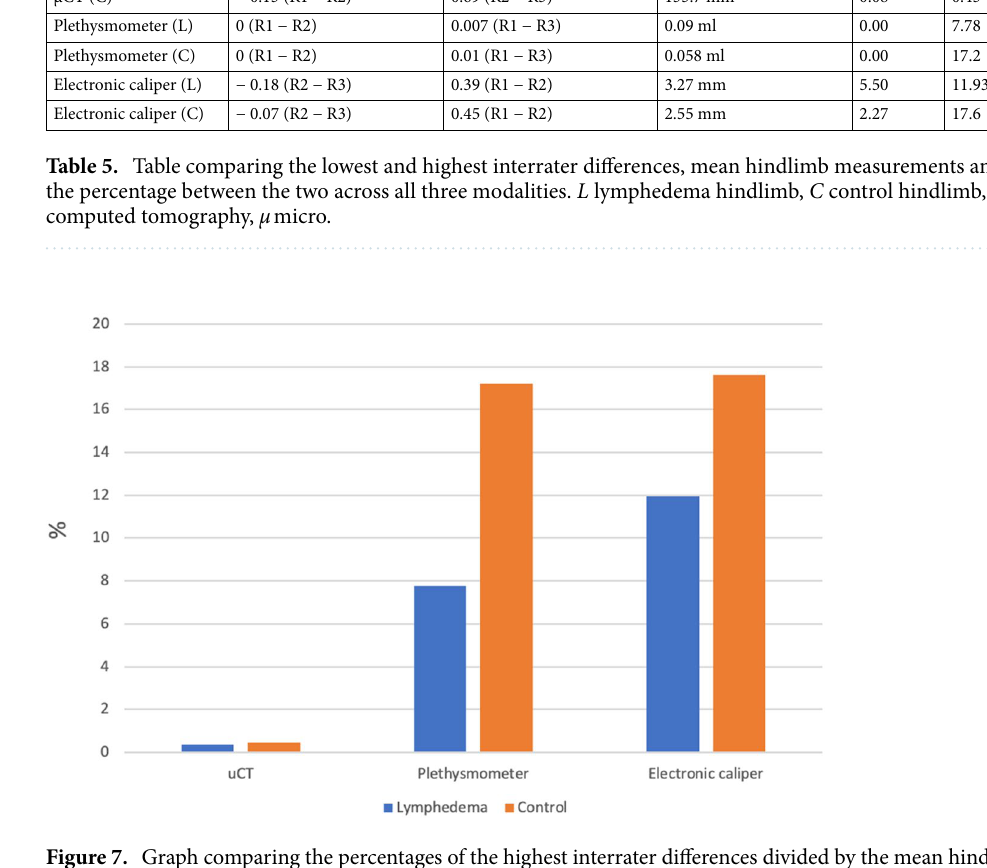
Figure 7. Graph comparing the percentages of the highest interrater differences divided by the mean hindlimb measurements across all three modalities. L lymphedema hindlimb, C control hindlimb, CT computed tomography, μ